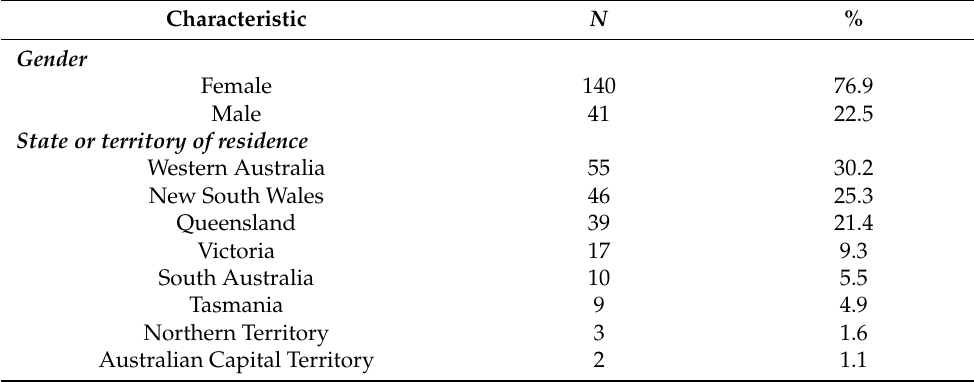
Table 1. Demographic Characteristics of the Participant